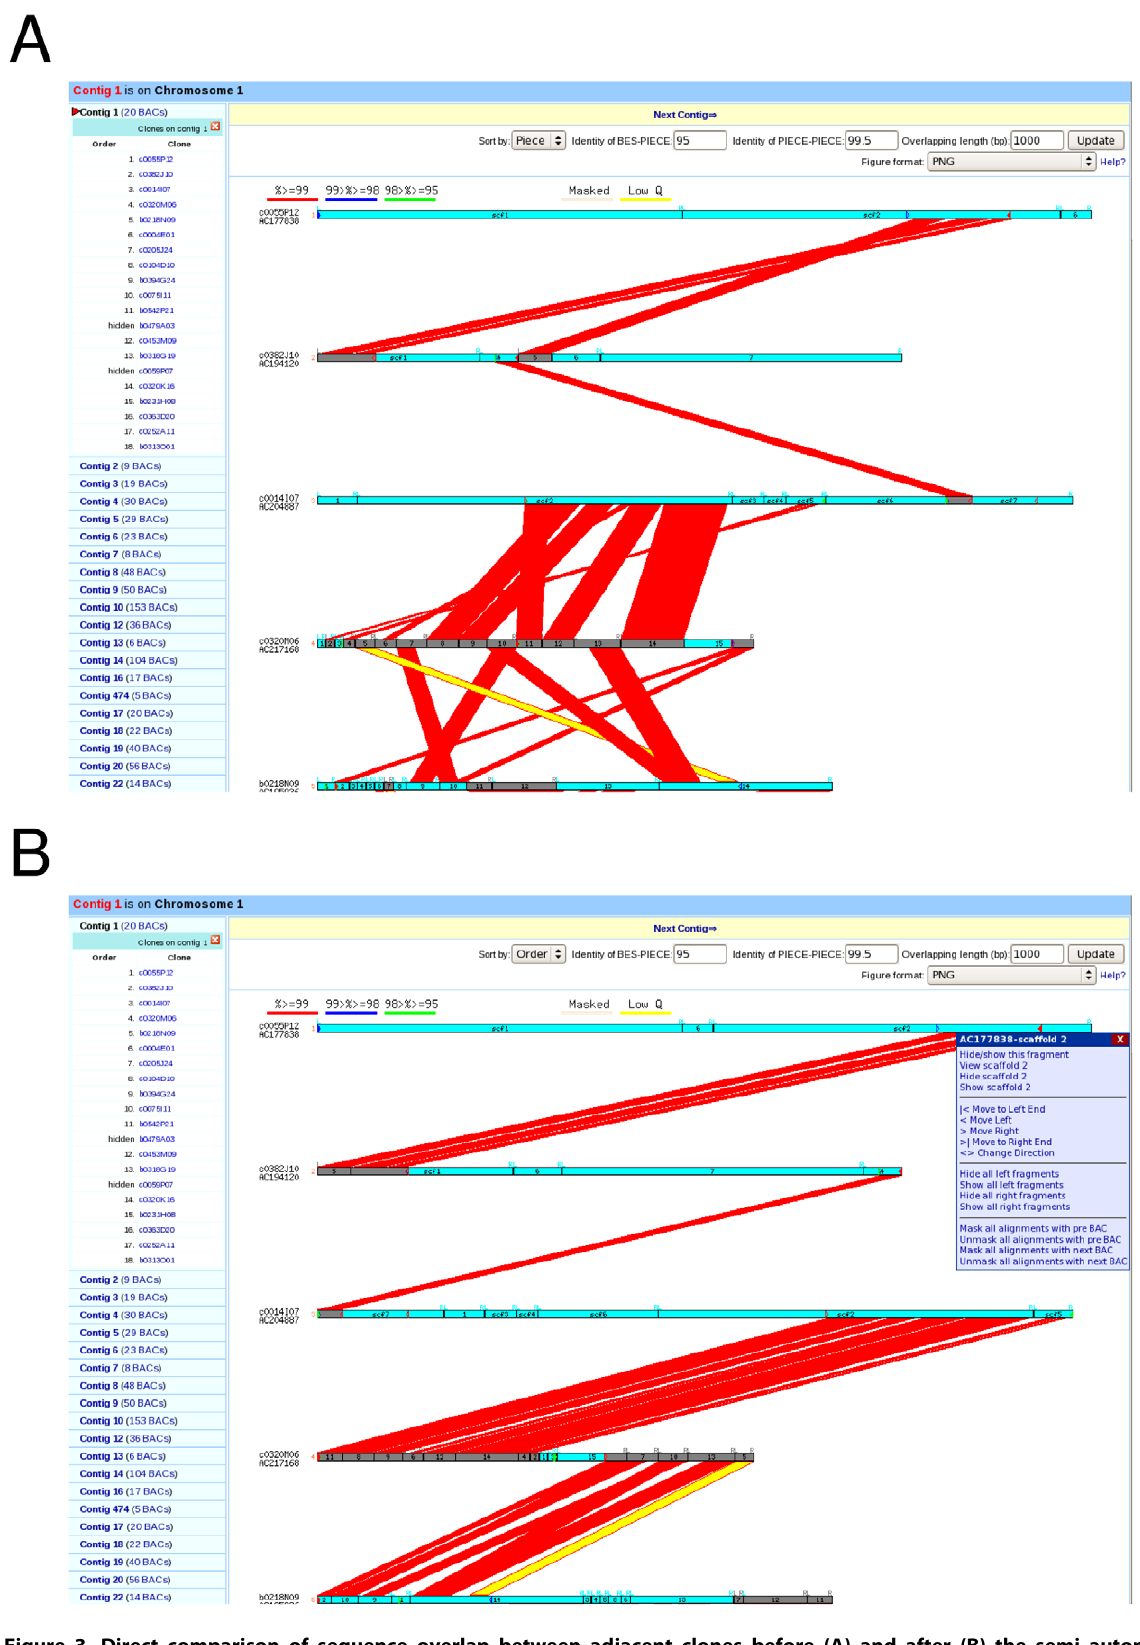
Figure 3. Direct comparison of sequence overlap between adjacent clones before (A) and after (B) the semi automated AGP pipeline.